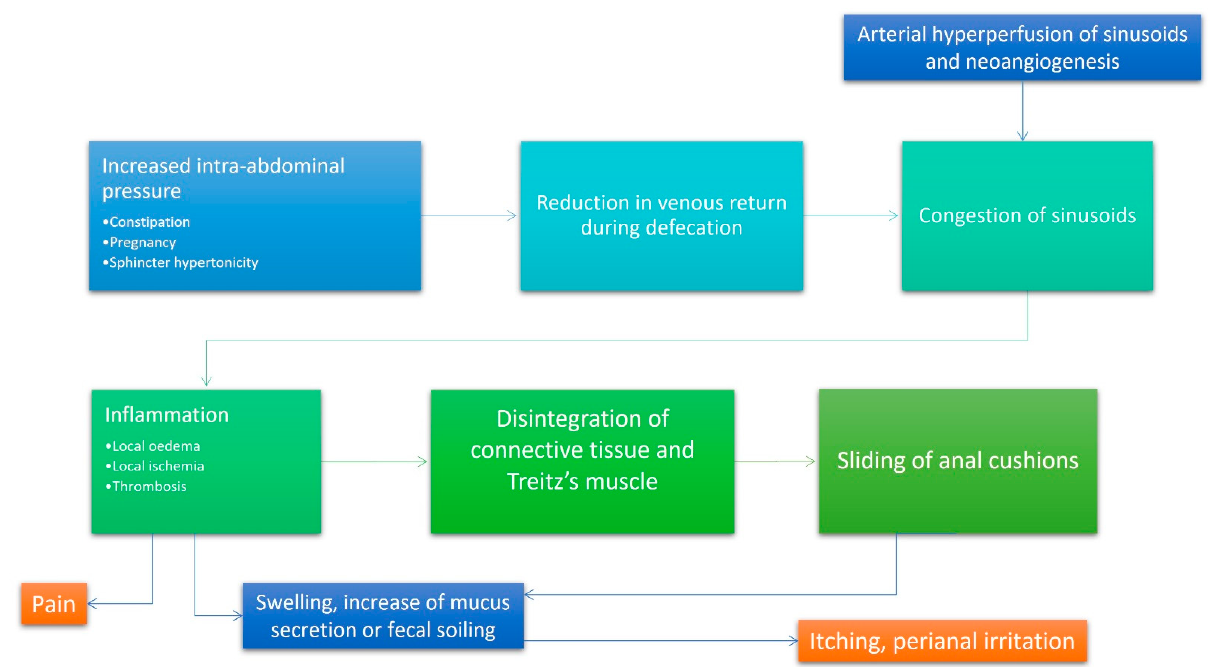
Figure 1. Integrated algorithm summarizing contemporary thinking regarding the pathophysiology of haemorrhoids. According to the current accepted physiopathological mechanism of hemorrhoidal disease, increased intraabdominal pressure (due to constipation, diarrhoea, pregnancy, or obstructed defecation) and arterial hyperperfusion of the hemorrhoidal plexus represents the most important initiation points. The subsequent reduction of venous return during defecation and stagnation of blood inside the dilated plexus favour inflammation and its epiphenomena (oedema, ischemia and thrombosis). Inflammation is responsible of the impaired quality of collagen and relaxation of the supporting muscles of the internal hemorrhoidal plexus. These events lead to sliding of the anal cushions that is responsible for all symptoms experienced in haemorrhoids.